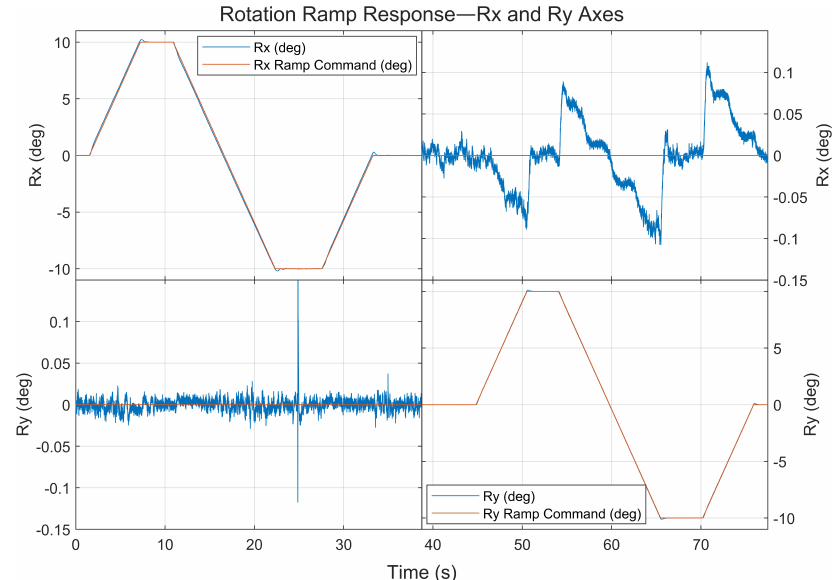
Figure 17. ψ – θ axes ramp